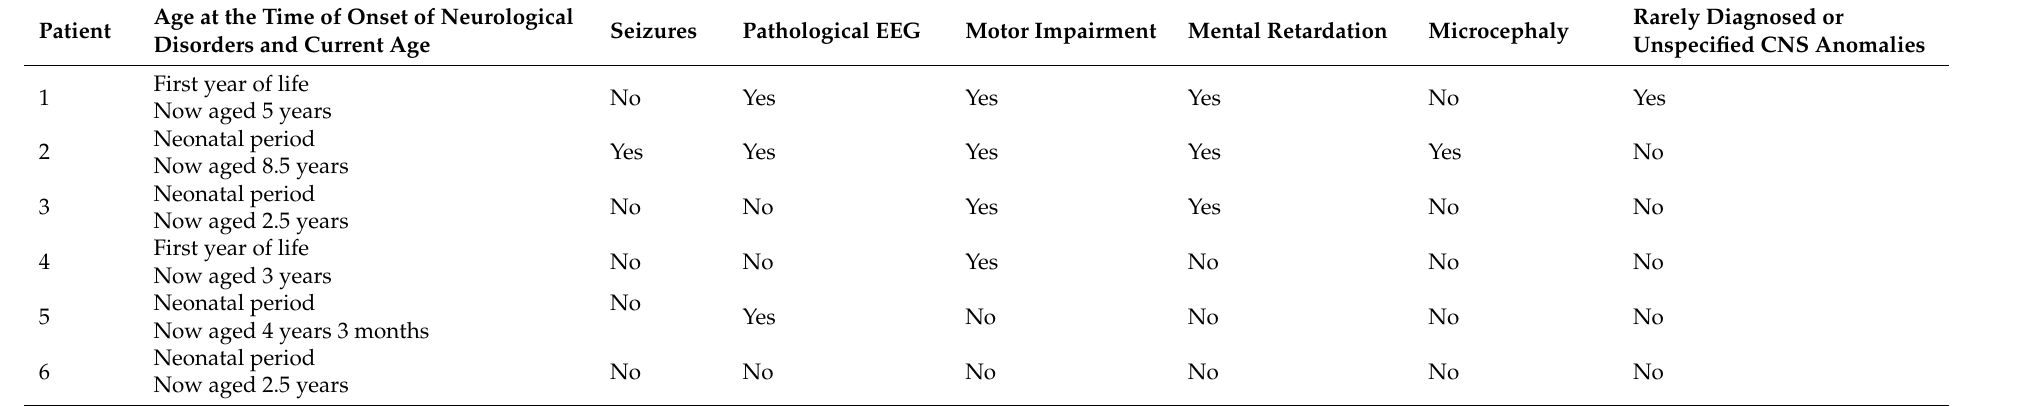
Table 2. Different clinically diagnosed CNS anomalies according to clinical